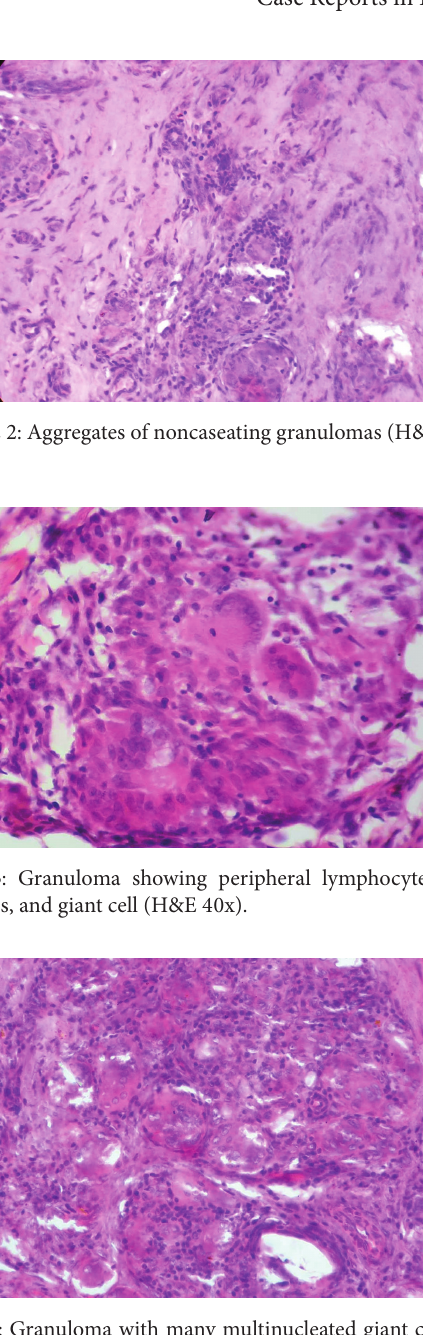
Figure 4: Granuloma with many multinucleated giant cells (H&E